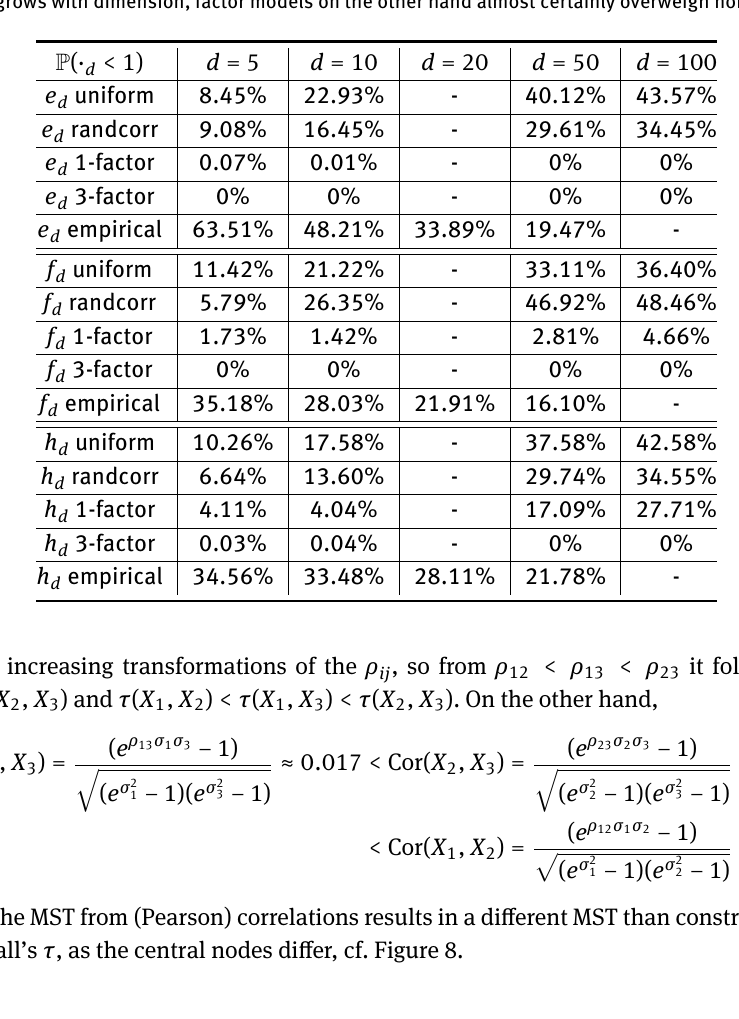
Table 5: Probability of underweighting non-central assets in terms of e d / f d / h d , P ( e d / f d / h d ( Ω ) < 1) , for different correlation